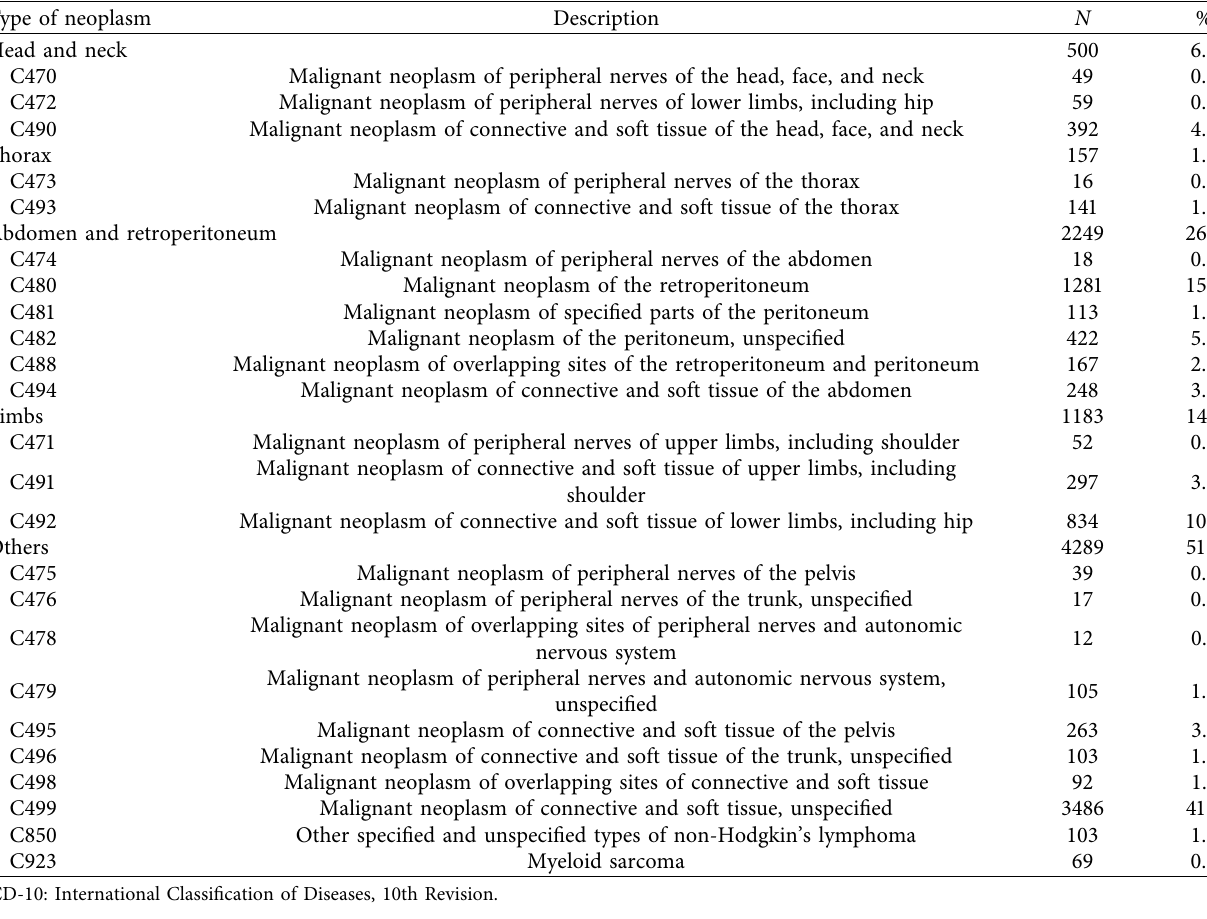
Table 3: Details of neoplasms by three-digit ICD-10 codes.